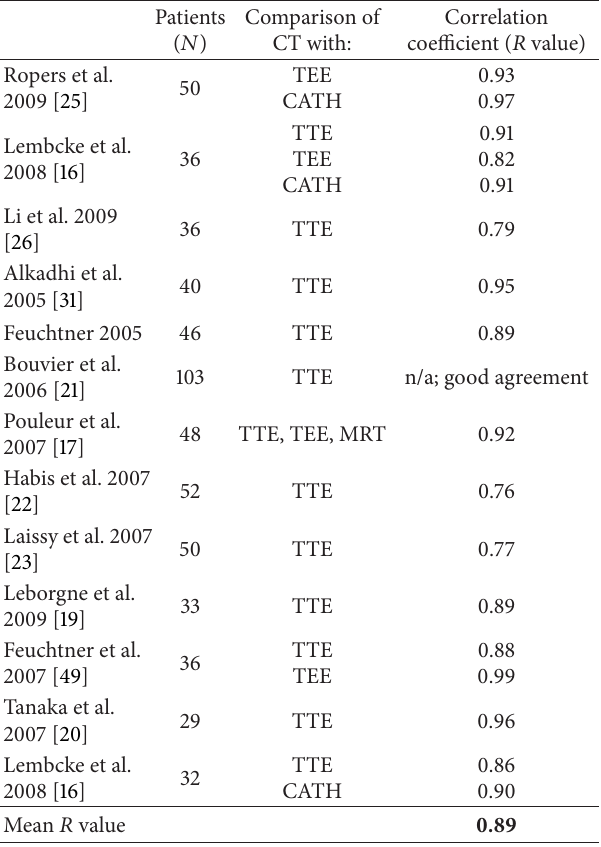
Table 1: Aortic valve area (AVA) sizing. Correlation of CT with echocardiography, fluoroscopy, and